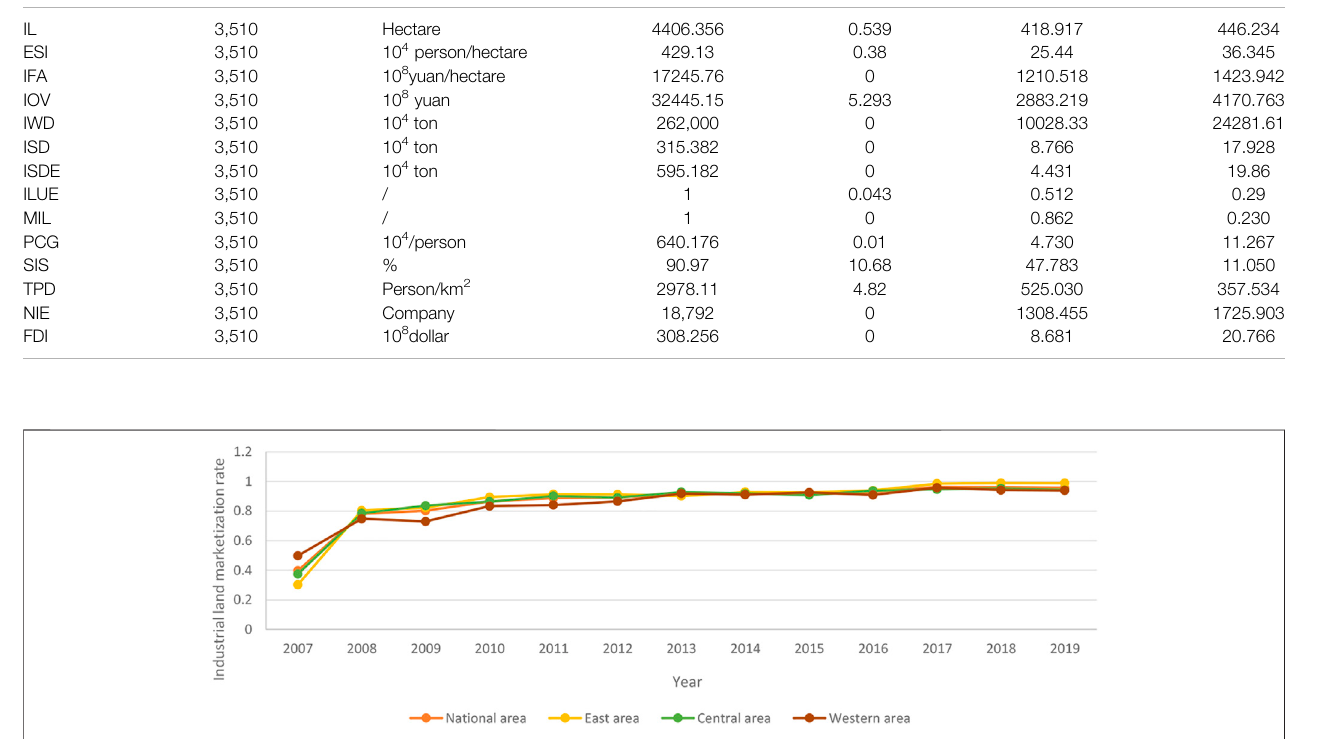
TABLE 1 | Statistical description of the selected variables. Variable